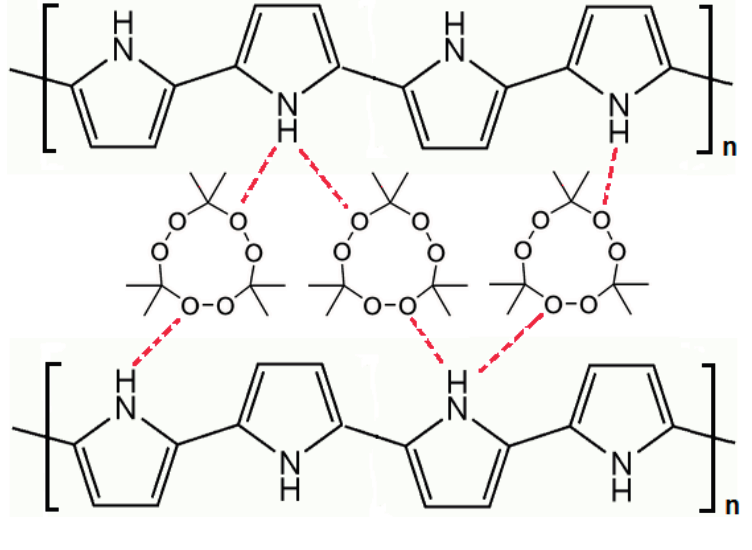
Figure 5. Schematic representation to describe the hydrogen bonding interactions between the TATP molecule and pyrrole units during template trapping in molecular